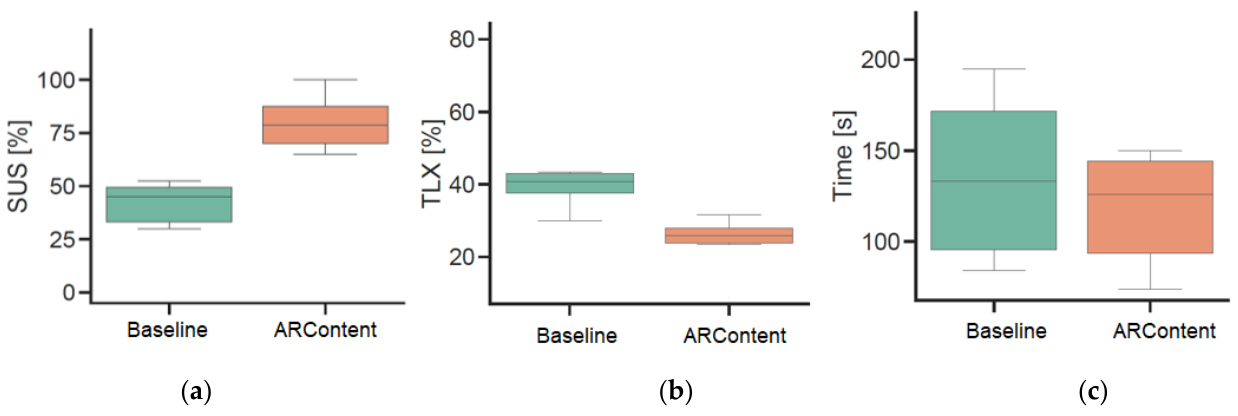
Figure 12. Summary of results against the baseline: ( a ) SUS score; ( b ) TLX score; ( c ) time requested to complete the task.